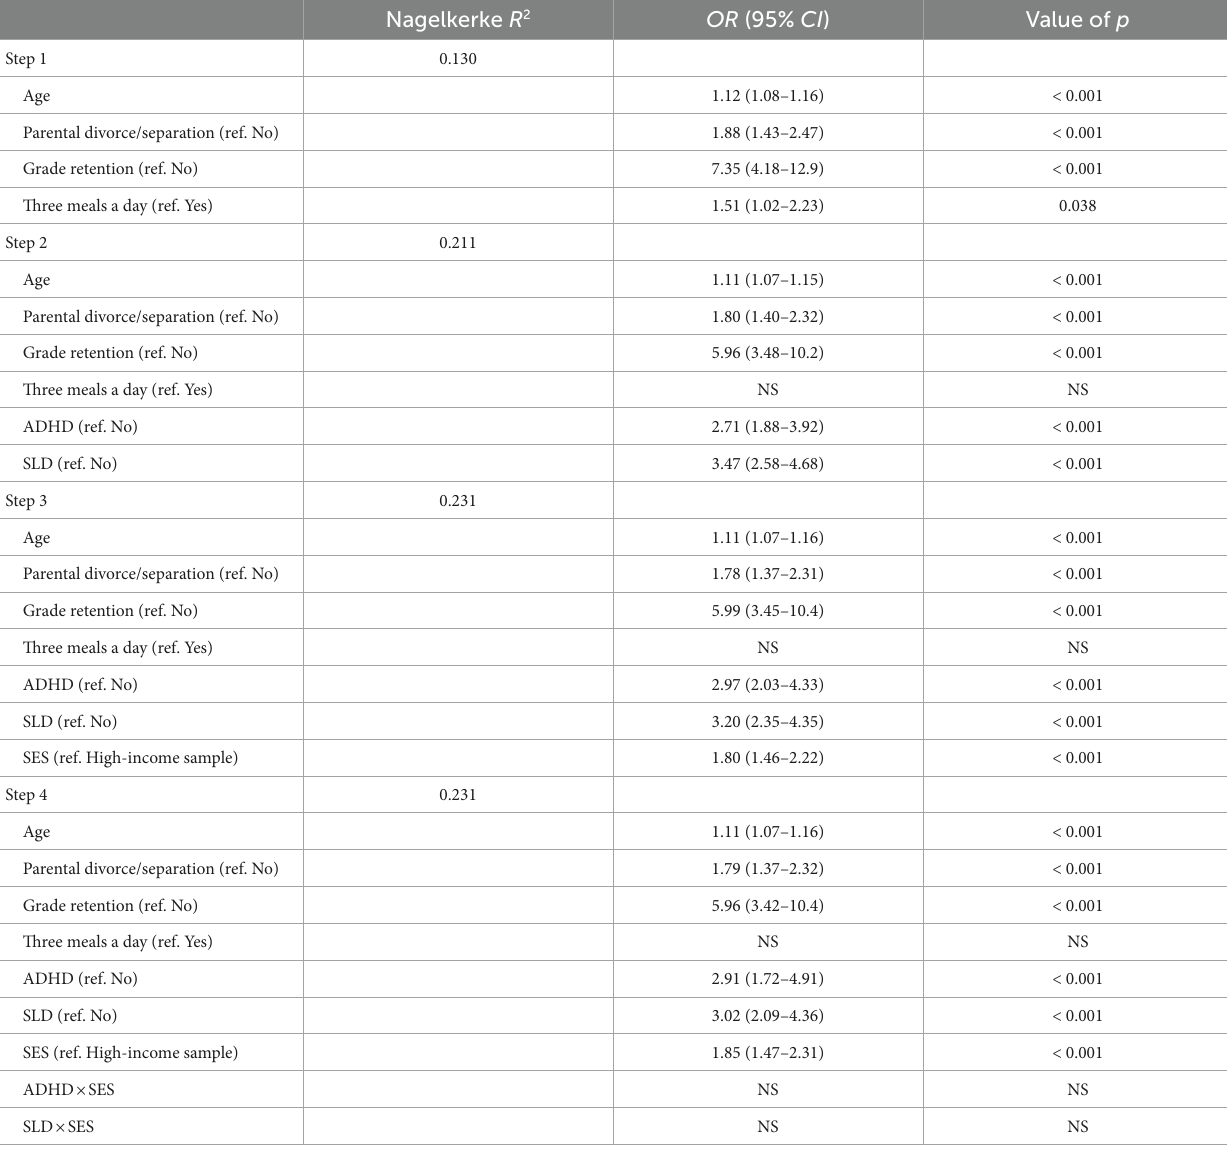
TABLE 6 Predictors of poor academic performance on